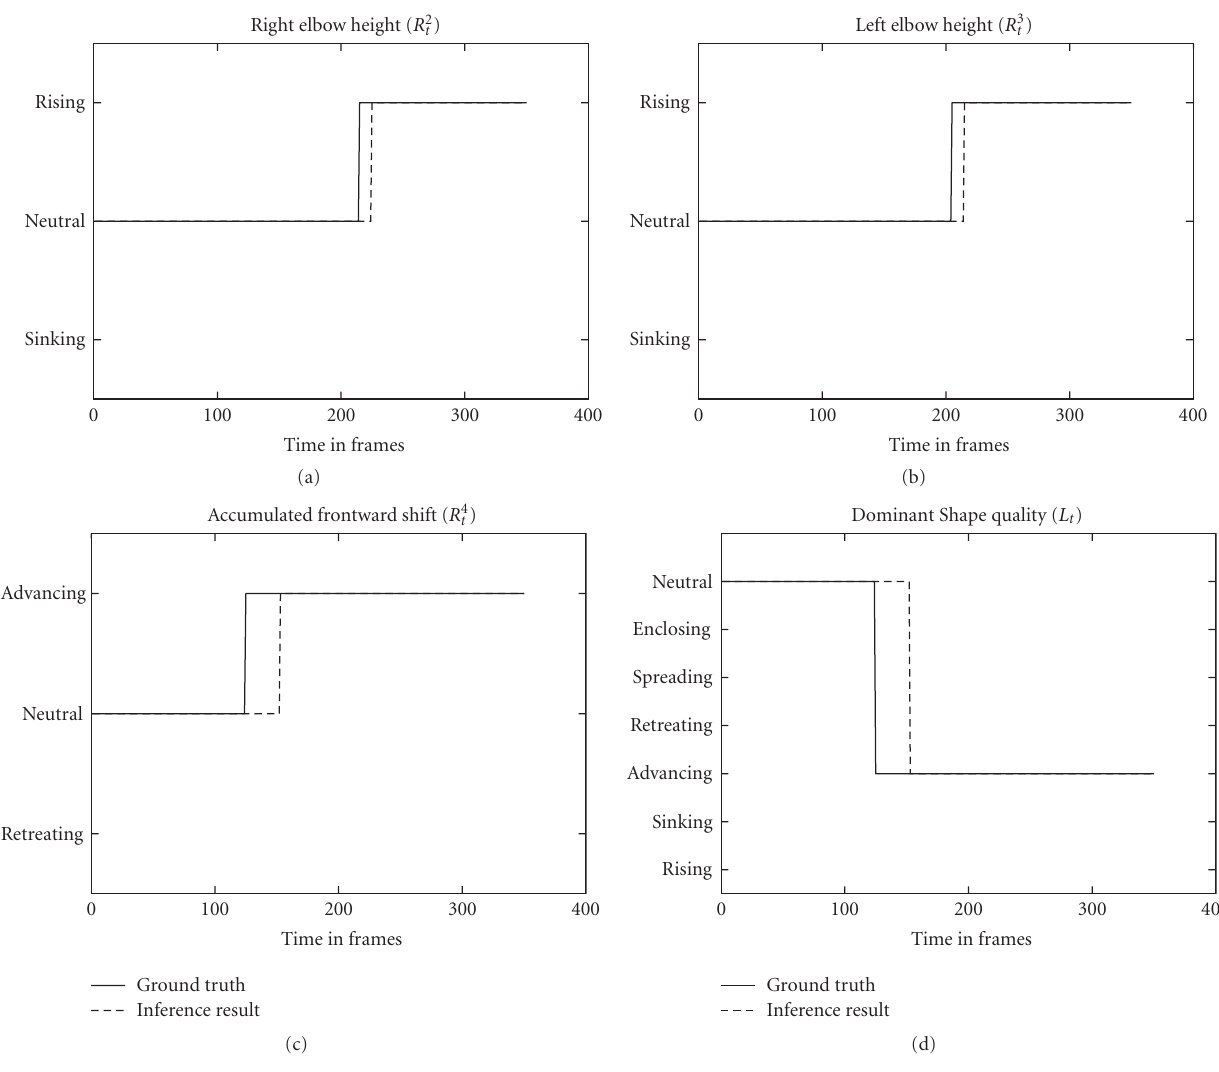
Figure 12: Dominant Shape quality segmentation performance on frames 1–350 of “Menu 3” (dancer 1) movement data shows that even though the person is advancing with the arms rising, our method correctly infers the dominant Shape quality as advancing.